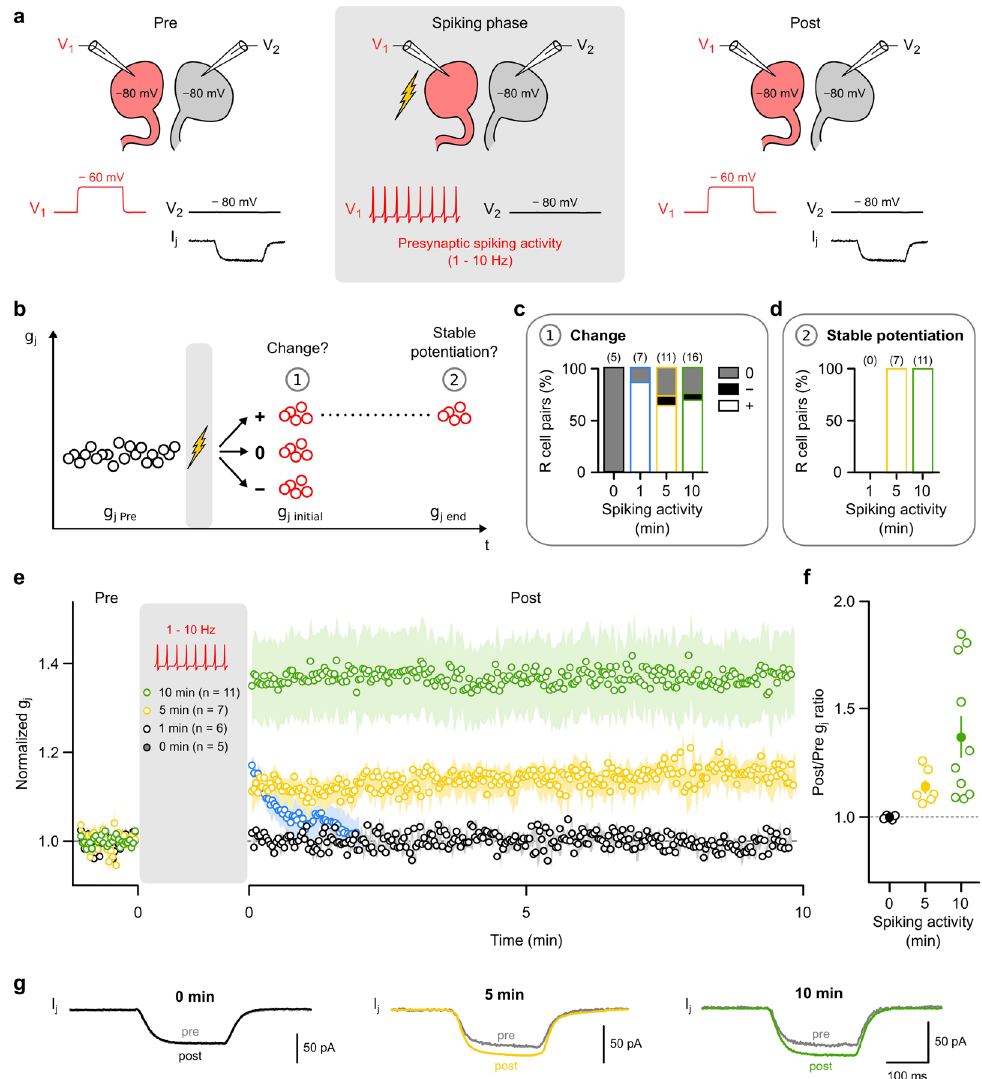
Figure 3. Innexin-based electrical synapses are capable of long-term potentiation (LTP). ( a ) Gap junctional conductance (g j ) was determined every 2 s before (pre) and after (post) a spiking phase (flash symbol) during which current (2 nA, in current clamp mode) was injected into one cell of the pair (presynaptic) to cause spiking for 1, 5 or 10 min at a rate between 1 and 10 Hz. The other cell (postsynaptic) remained voltage-clamped at − 80 mV (see Fig. S1). Additional controls (0 min) in which both cells remained voltage clamped throughout the experiment confirmed the stability of g j in absence of the spiking phase. ( b ) After the spiking phase, the average g j (g j initial ) of the first 5 trials (i.e. the first 10 seconds) was used to form three categories: potentiation ( + ; g j initial > mean g j Pre + SD Pre ), depression ( − ; g j initial < mean g j Pre − SD Pre ) and no change (0). If a change had occurred, its stability was assayed using the average g j of the last 5 trials of the 10 min observation period (g j end ). To be considered stable, we required g j end > g j initial − SD initial . ( c ) Proportion of R cell pairs with increased (white), decreased (black) or unchanged (grey) g j initial after the prior spiking phase of either 1, 5 or 10 min. ( d ) Proportion of R cell pairs in which an initial increase in g j was stable, i.e. all of the recordings after 5 min and 10 min, but none after 1 min. ( e ) Normalized g j (mean ± SEM) before and after the prior spiking phase (1, 5 or 10 min) averaged across all those R cell pairs shown in ( c ) that showed initial potentiation. Additionally, averaged controls without spiking activity (0 min) are shown to illustrate stability of g j in absence of a spiking phase. ( f ) Ratio of the average g j during the 10 min observation period (Post) and the respective average baseline g j (Pre) for each R cell pair shown in ( e ). Mean values, averaged across the R cell pairs, are indicated by filled dots. ( g ) Average junctional currents (I j ) in representative experiments before (pre) and after (post) 0 min (black), 5 min (yellow) or 10 min (green) of presynaptic spiking decrease, then the average g j , measured 10 min after the initial phase, was still significantly larger than the base- line level (p < 0.05, two-tailed paired Wilcoxon test; Fig. S4b). These results showed that it was BAPTA-AM and not the solvent that inhibited the induction of LTP (Fig. 4d,e,f). Hence, innexin-based electrical synapses use calcium-dependent regulatory mechanisms for long-term potentiation.